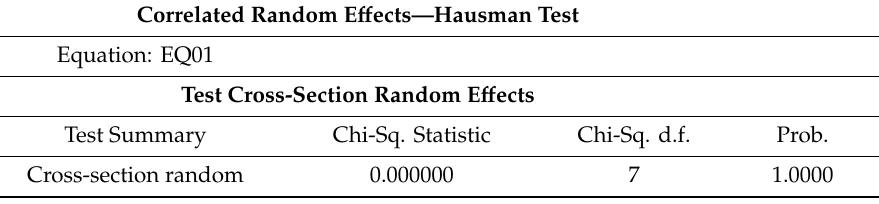
Table 6. Results of the Hausman test.